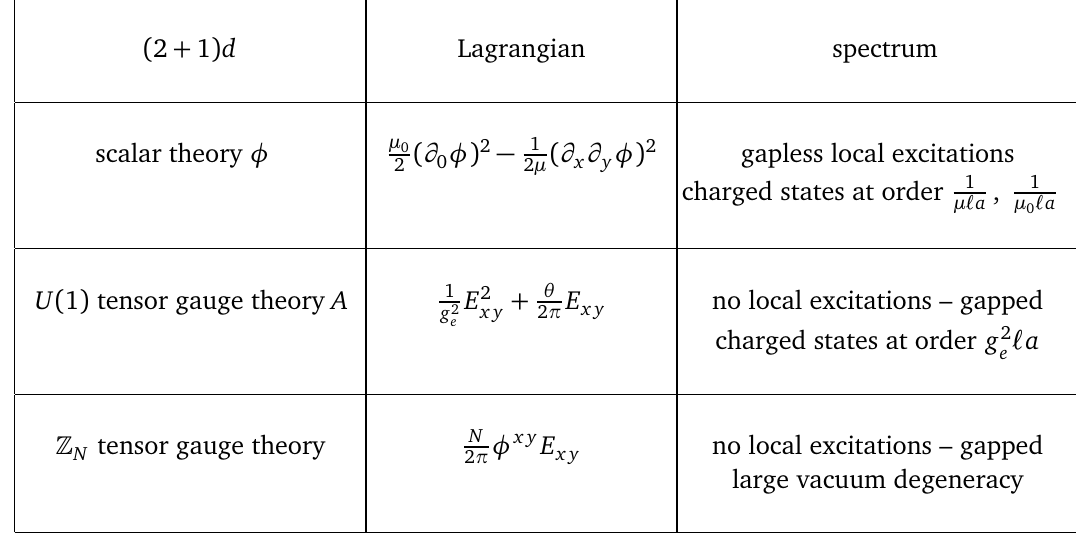
Table 2: Spectra of the continuum field theories discussed in [ 3 ] . Depending on the order of limits a → 0 or (cid:96) → ∞ , the energy of the charged states goes to zero or